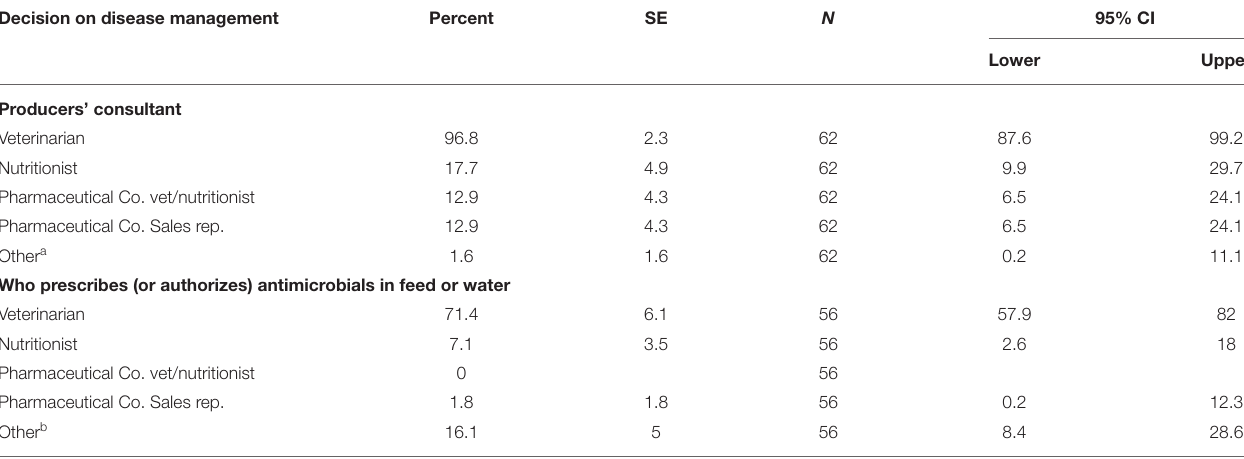
TABLE 10 | Consultation and prescription of antimicrobial drugs used to manage diseases in preweaned calves on California dairies. Decision on disease